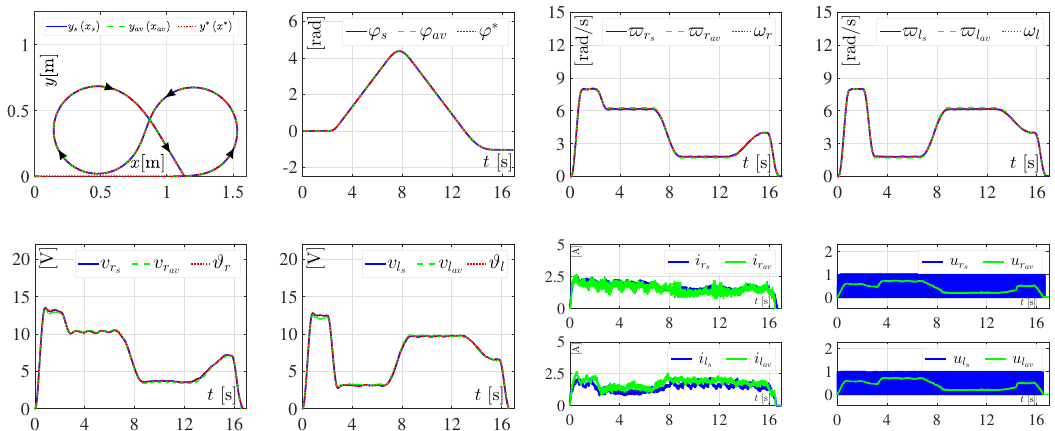
Figure 6. Experimental results in closed-loop when variations in E r and E l appear. The corresponding results of the hierarchical switched controller are represented by y s ( x s ) , ϕ s , (cid:118) r and u l . The results associated with the hierarchical average controller are denoted by y av ( x av ) , ϕ av , s (cid:118) r , (cid:118) l , v r , v l , i r , i l , u r , and u l av av av av av av av av